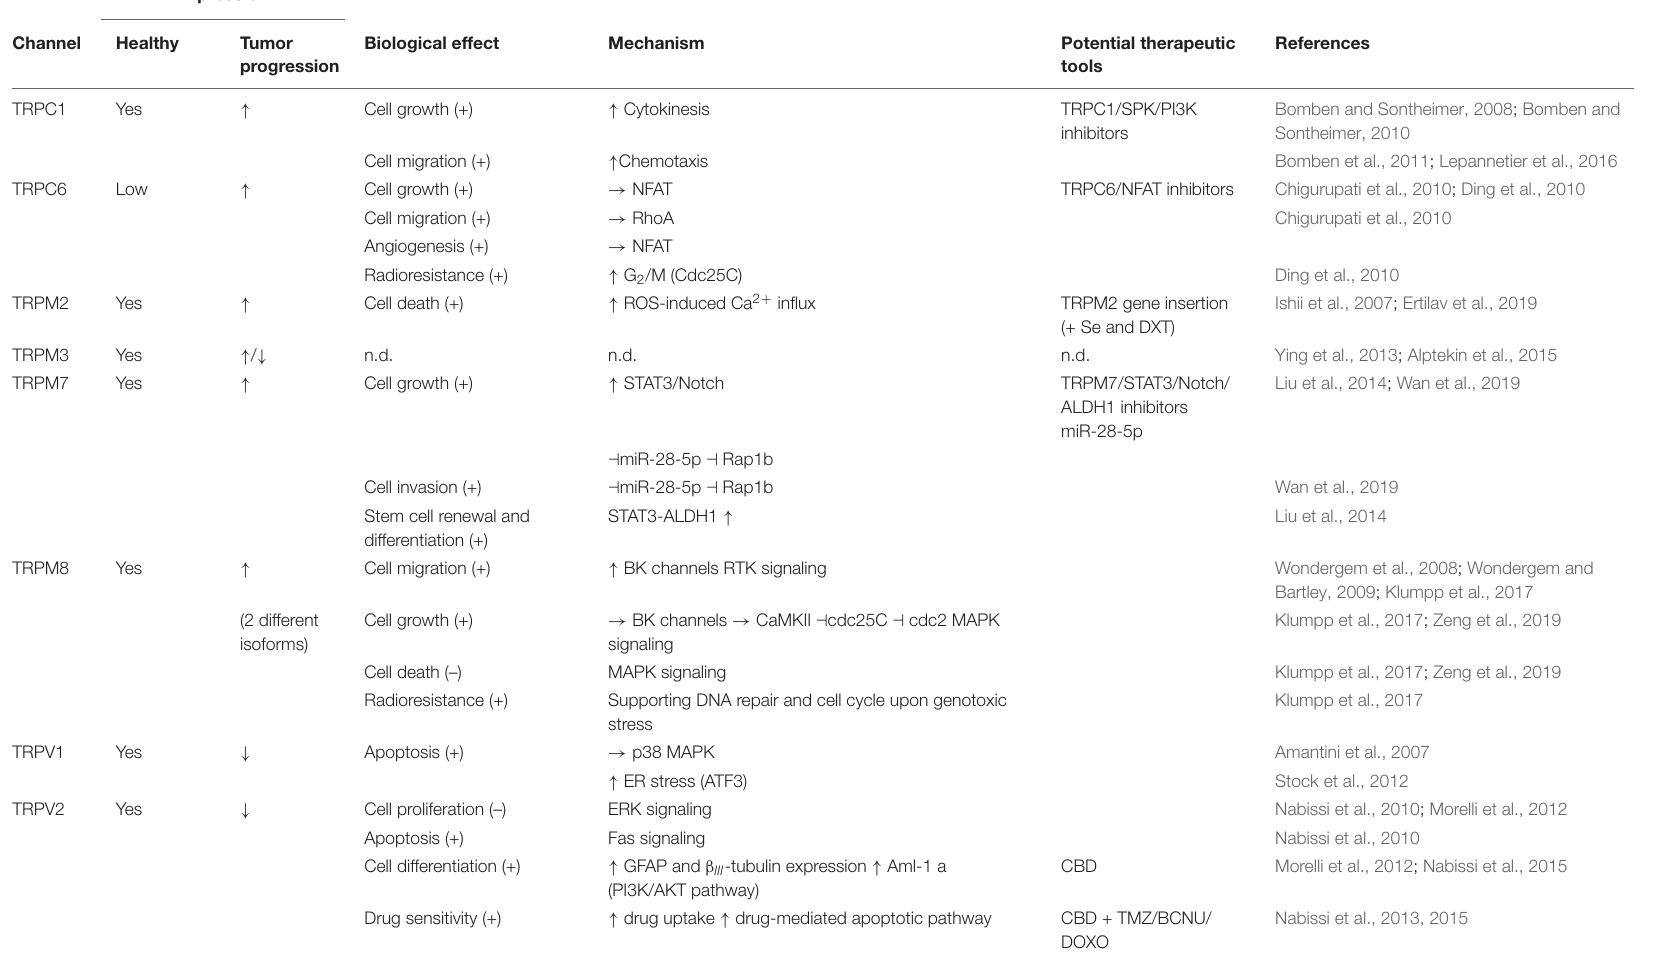
TABLE 1 | TRP channels expression and functionality in